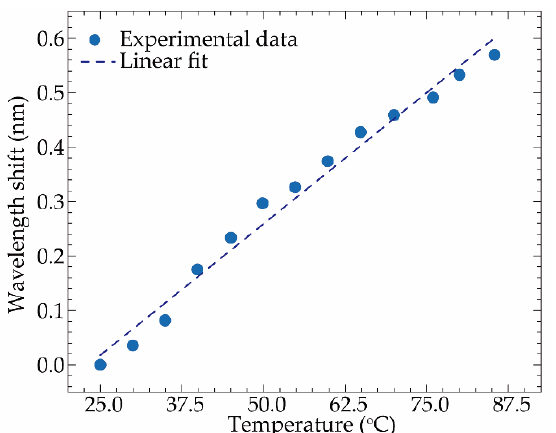
Figure 7. Sensor wavelength shift with temperature. The blue circles represent the experimental data, and the dashed blue line represents the linear fit applied for the temperature range between 25.0 and 87.0 °C.